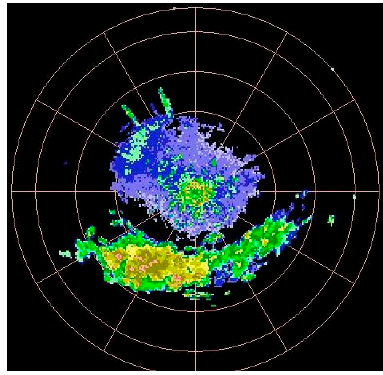
Figure 9. Visualization of a surface of radar data.